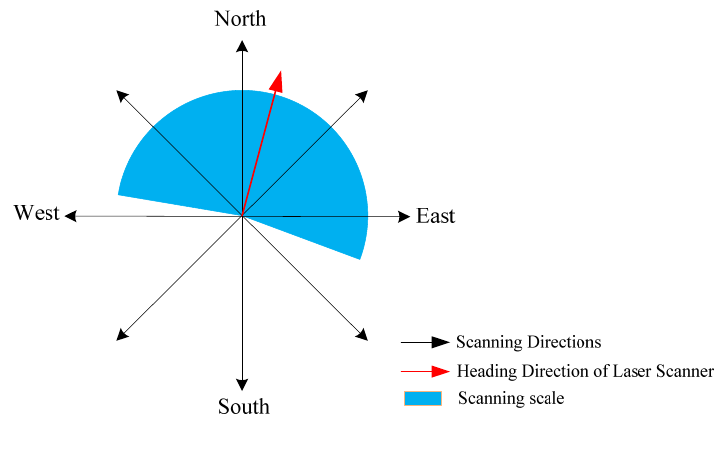
Figure 7. Selection of spare directions for ray tracing. The directions in the scanning scale of the laser sensor are chosen for the ray tracing